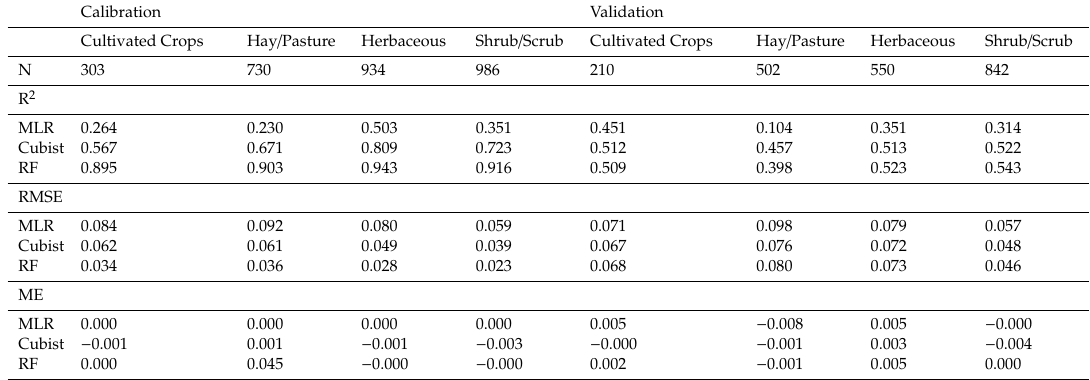
Table 5. Model performance for di ff erent methods within di ff erent land cover types calculated for calibration and validation datasets. Abbreviations: N, number of samples; R 2 , coe ffi cient